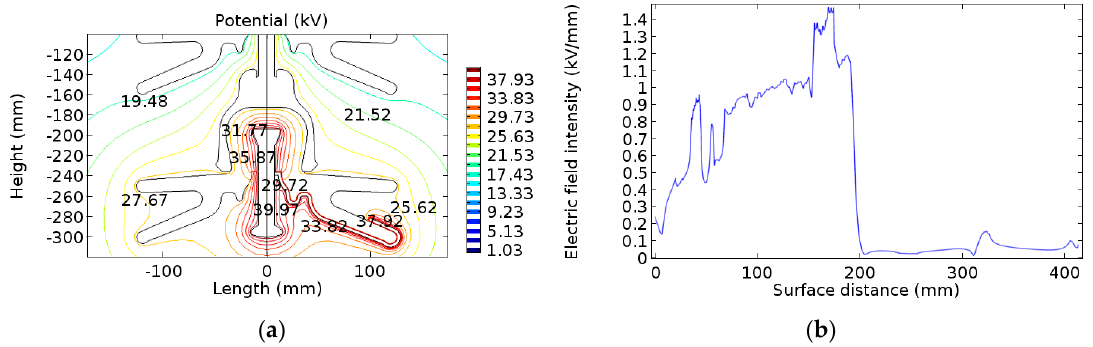
Figure 20. Simulation results of Extension 5: ( a ) equipotential line distribution; ( b ) electric field distribution along No. 1 insulator.